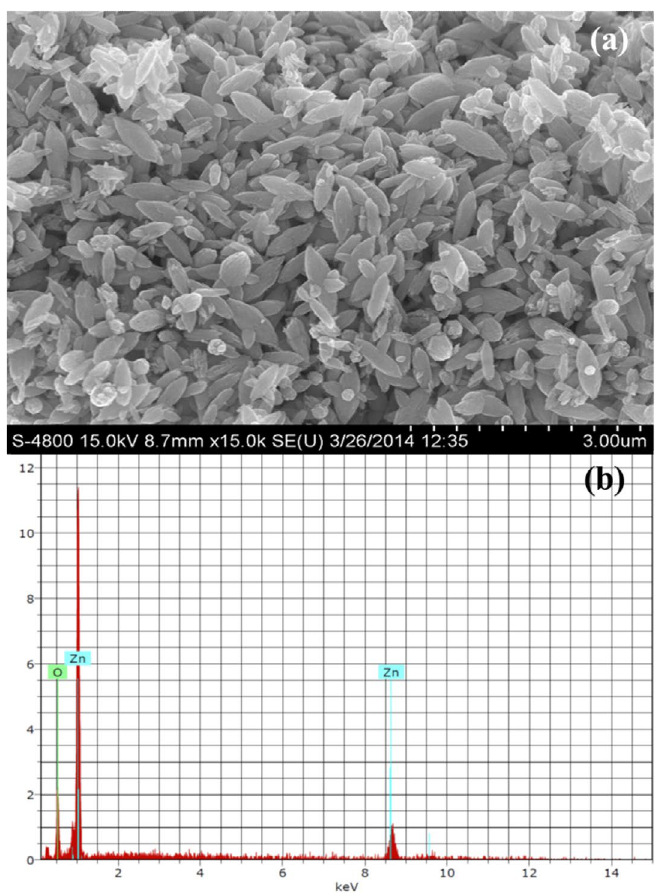
Fig. 1. (a) The SEM image of nano ZnO (b) The EDX spectrum of nano ZnO catalyst